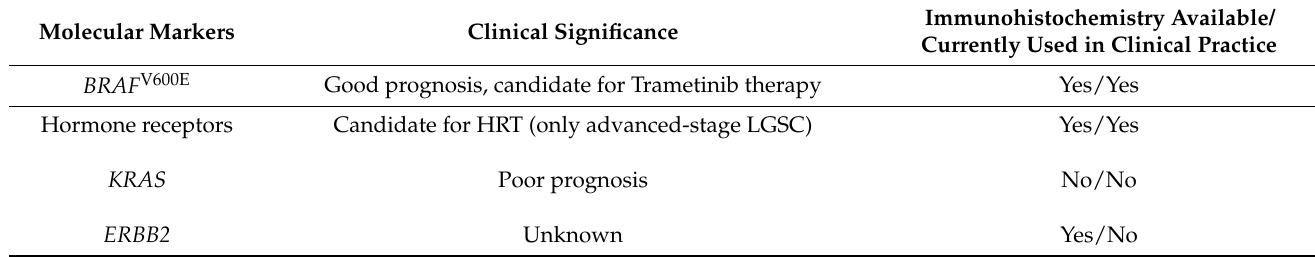
Table 2. Molecular markers in low-grade serous